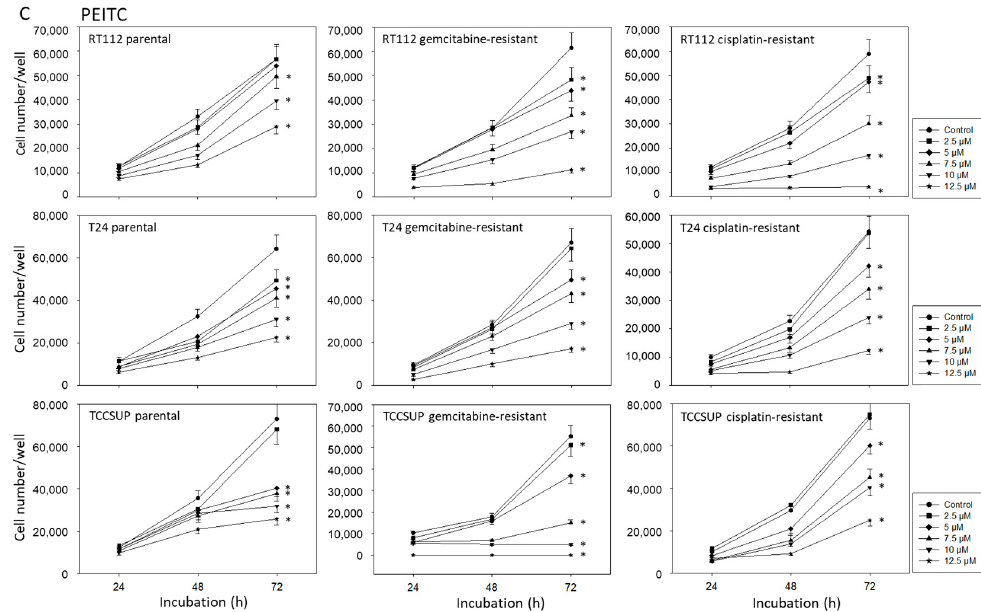
Figure 3. ( A – C ) Influence of BITC ( A ), AITC ( B ) and PEITC ( C ) on growth of parental, cisplatin- and gemcitabine-resistant RT112, T24, and TCCSUP bladder cancer cell lines. Cell number was evaluated after 24, 48, and 72 h by the MTT assay. Error bars indicate standard deviation (SD), n = 5. * indicates a significant difference to the non-treated control.